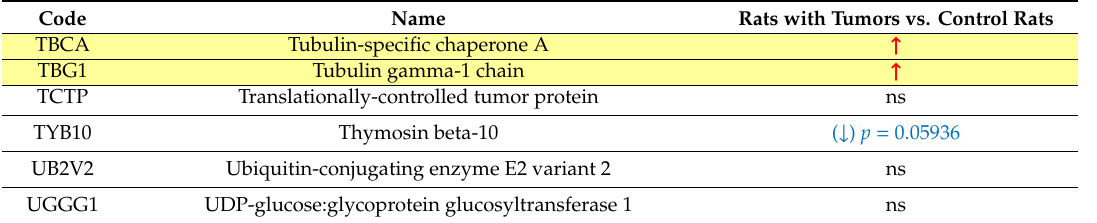
The eight main proteins of interest are highlighted with arrows indicating the direction of change. Three additional proteins of interest showed strong tendencies (0.050 < p < 0.063). ns = di ff erences not significant ( p > 0.07), nd = proteins not detected in spleen samples, yellow = increase, green = decrease.